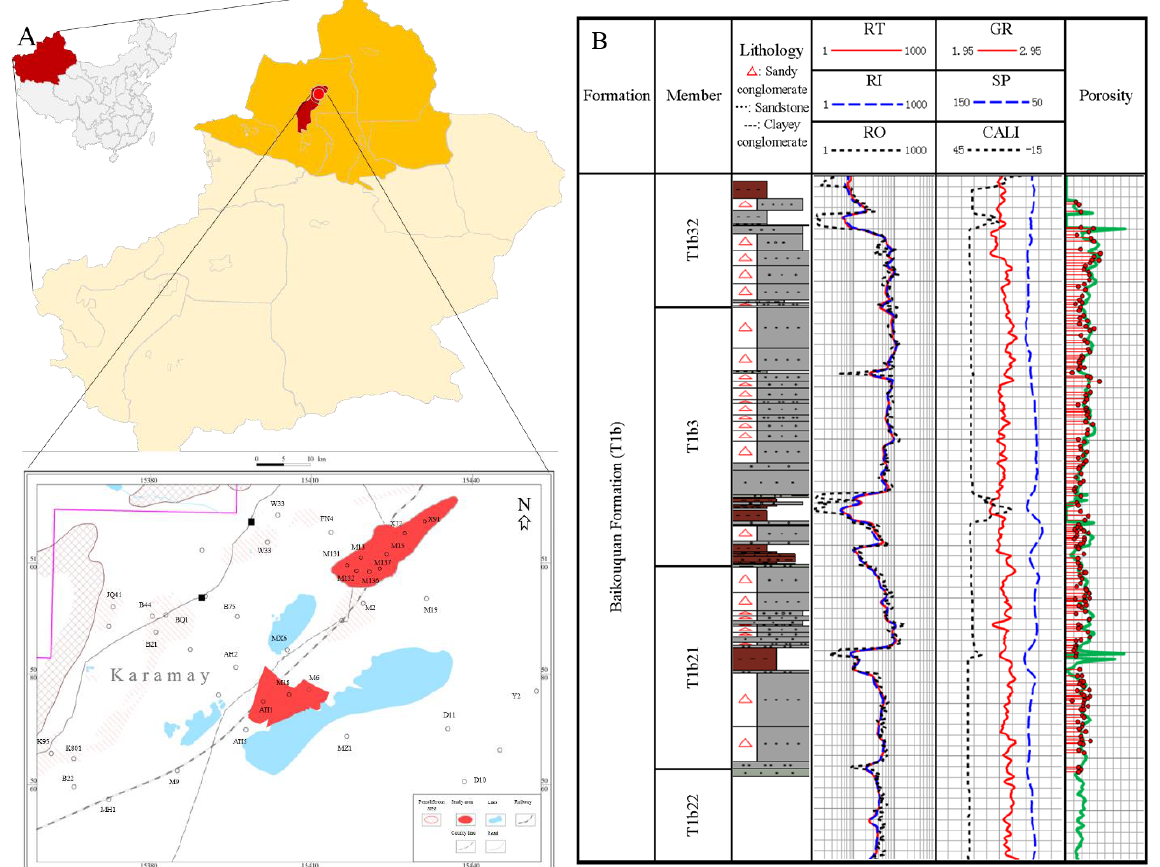
Figure 1. ( A ) Map showing the geographic location of the study area and the location of the well; and ( B ) integrated histogram of the sedimentary facies in Well M136.